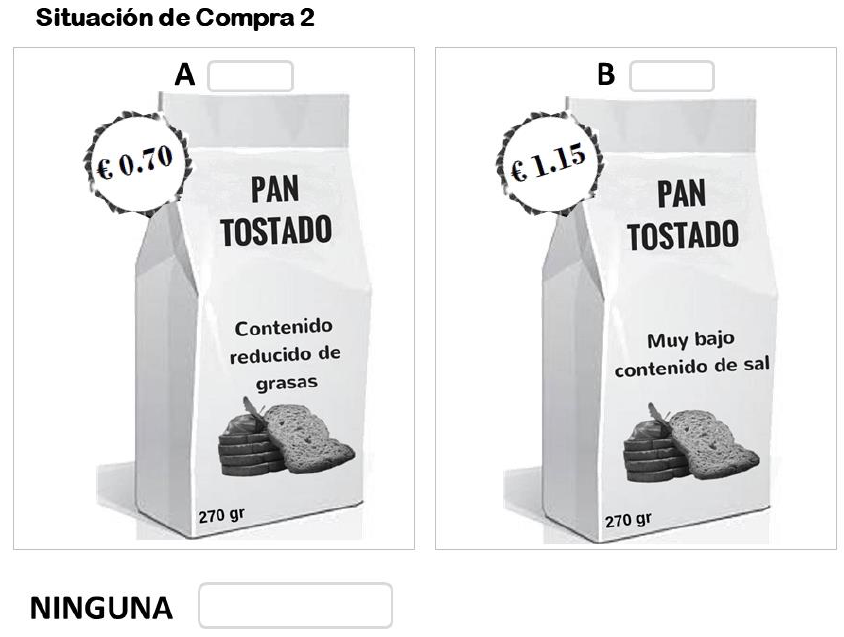
Figure 2. Example of a choice set.